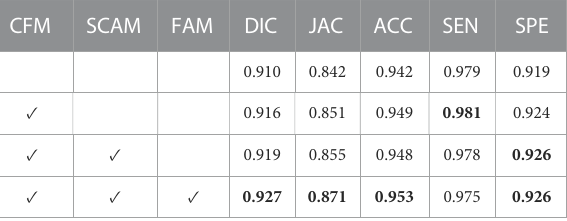
TABLE 3 Quantitative results for ablation studies on the ISIC-2016&PH2 test set.